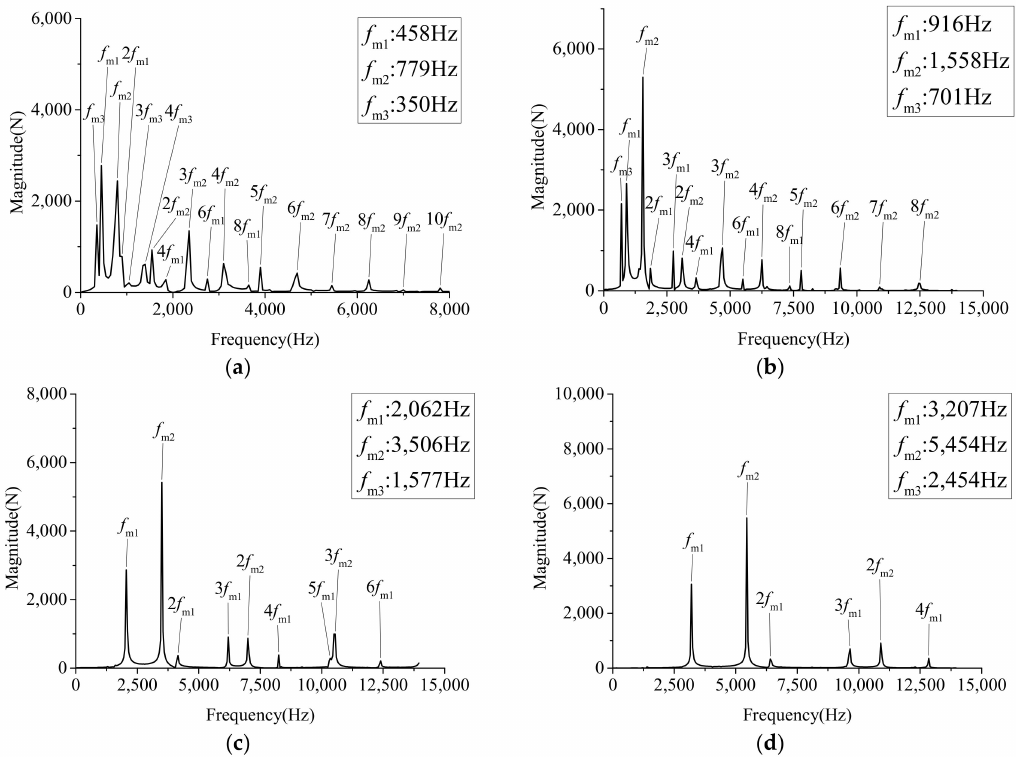
Figure 13. Spectrums diagram of meshing force of the second gear set at each input speed.